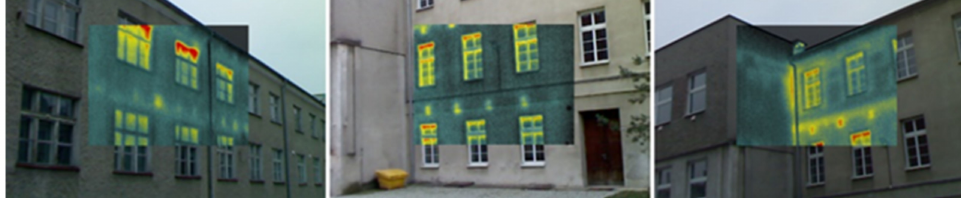
Figure 6. Location of point thermal bridges where steel beams are embedded in the external wall—the ends of the beams are clearly visible.